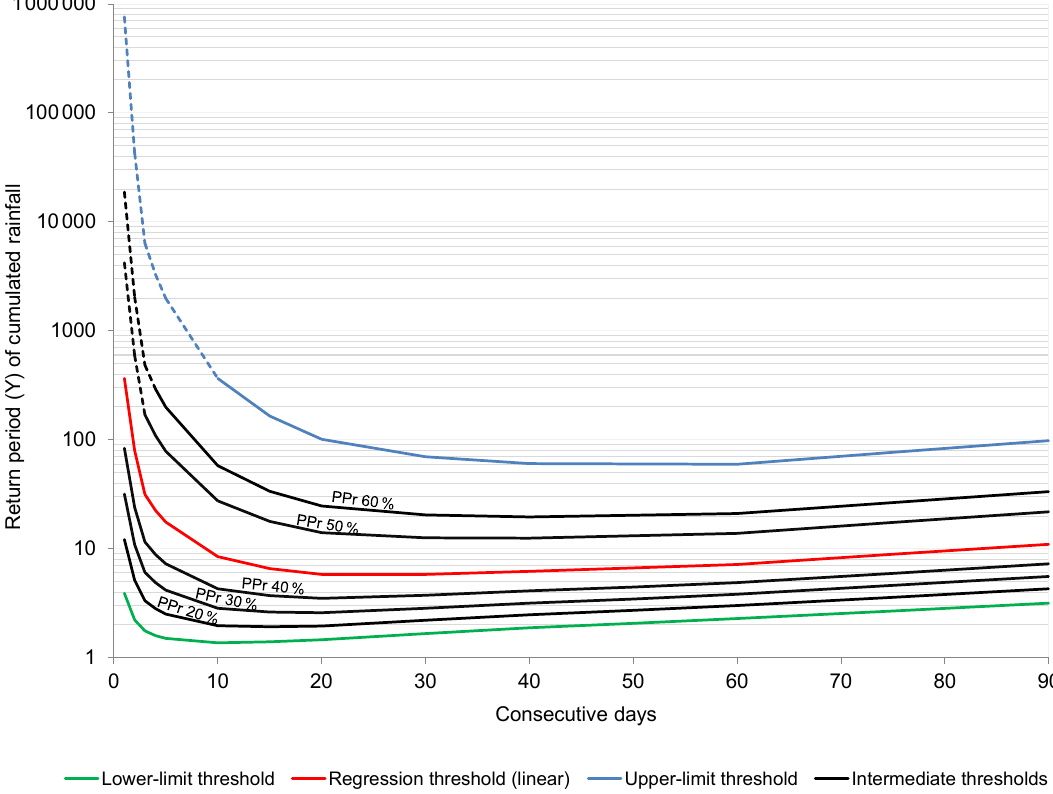
Figure 9. Return period of rainfall thresholds computed for the Lisbon region (linear regression, lower-limit, upper-limit and intermediate thresholds PP r 20%, PP r 30%, PP r 40%, PP r 50%, and PP r 60%). Dashed lines represent conditions never registered in the rain gauge.